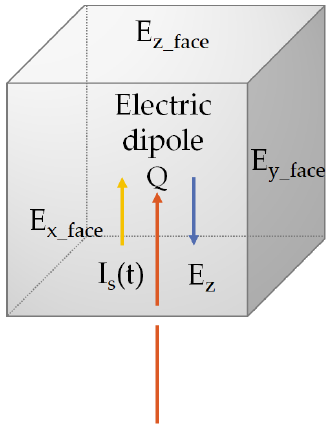
Figure 1. Charges and fields at a node of FDTD Yee cell.